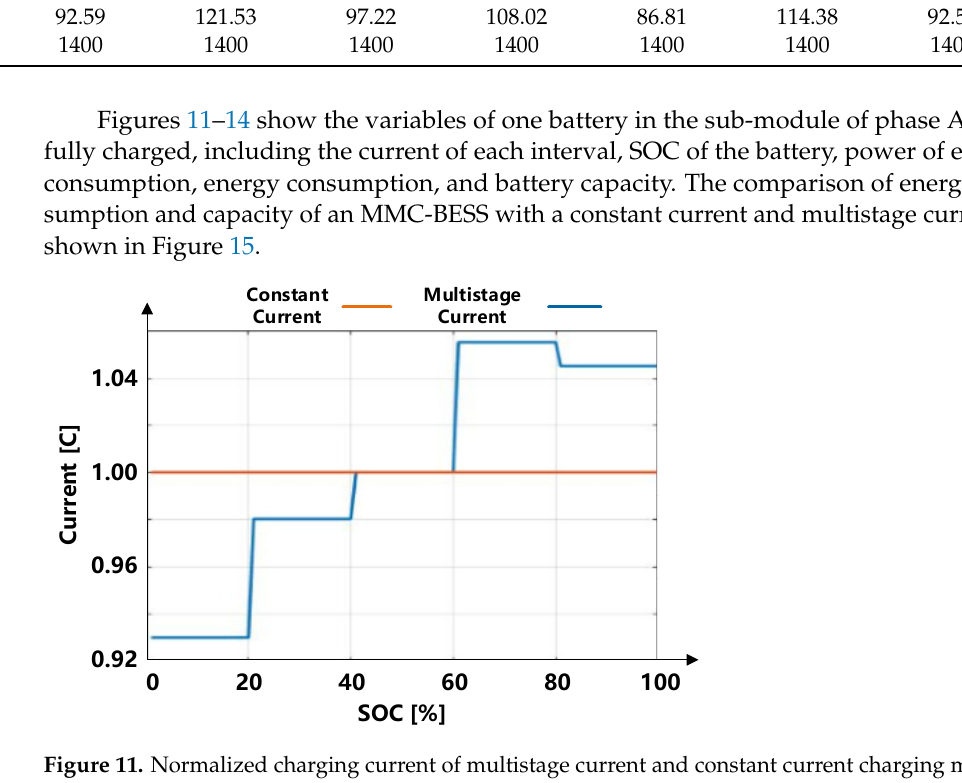
Figure 11. Normalized charging current of multistage current and constant current charging method of one battery in SM of phase A.